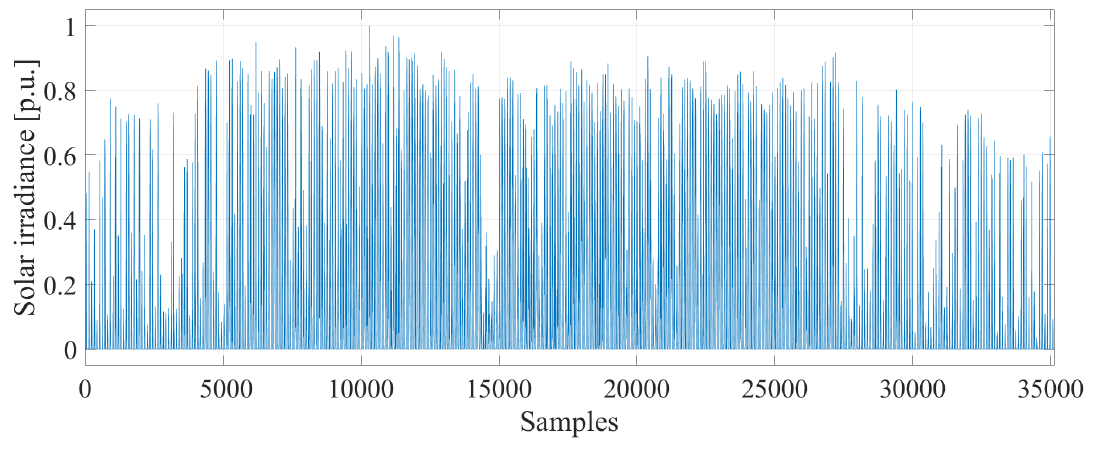
Figure 5. Solar irradiance profile used in the simulation model